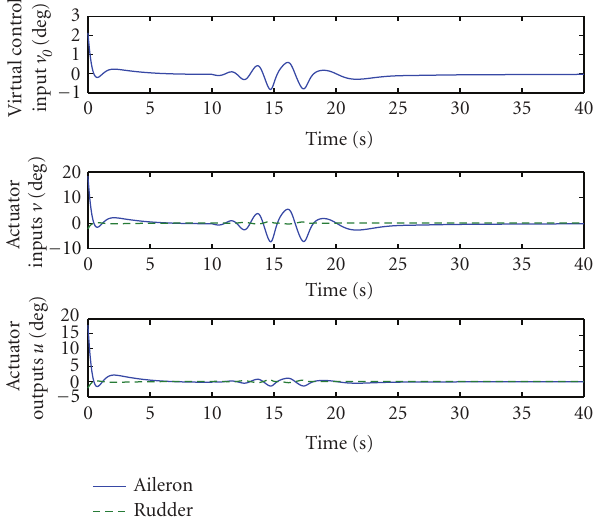
Figure 7: Time history of control signals and actuator outputs (Case 2).